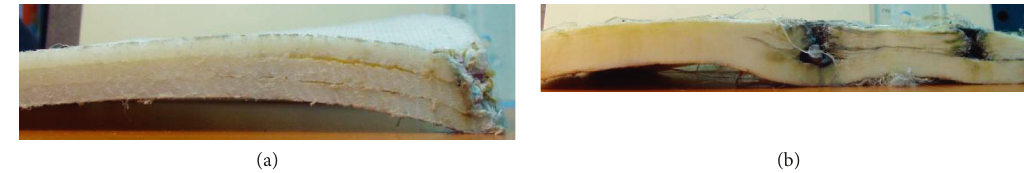
Figure 12: (a) Cross-sectional view of 3 plies of composite structures after impact; (b) Cross-sectional view of the laminated composite structure after impact.